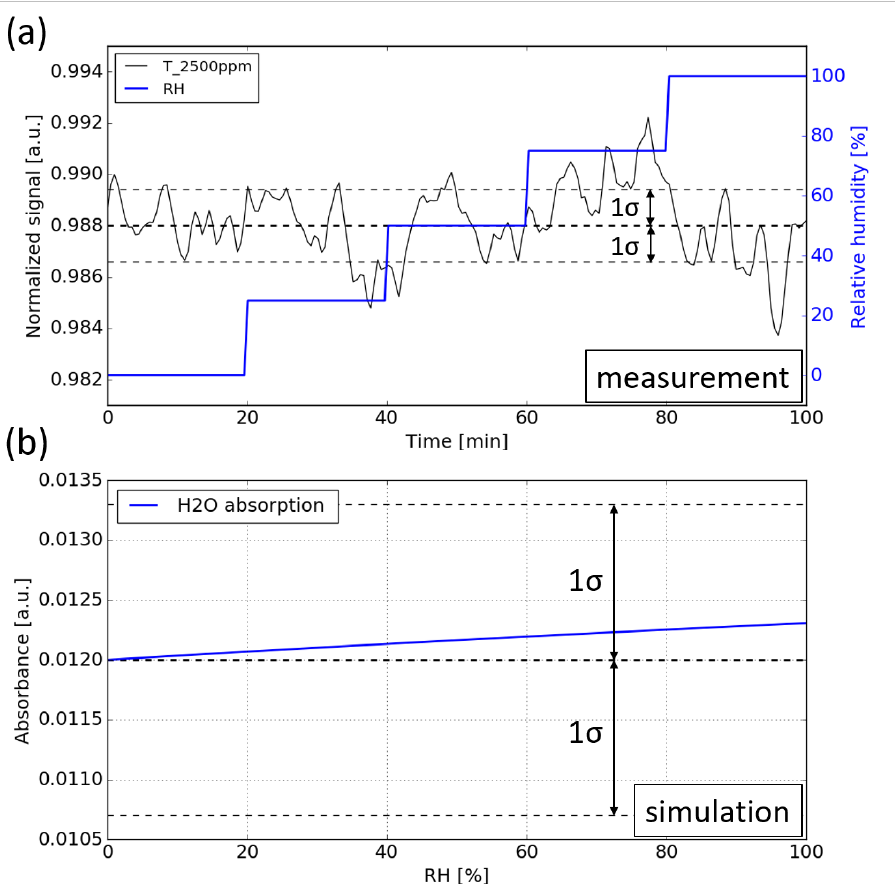
Figure 11. ( a ) Water interference measurement. During the measurement, the RH level is swept from 0 to 99% while the CO 2 concentration is kept at 2500 ppm. ( b ) Simulation of the water vapor absorption at various RH levels, the absorption of water is added on top of the absorption of 2500 ppm CO 2